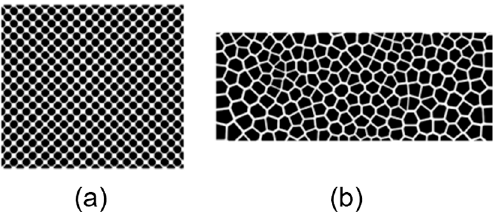
Figure 4. Examples of pa tt erns: ( a ) regular pa tt ern; ( b ) irregular pa tt ern based on Voronoi